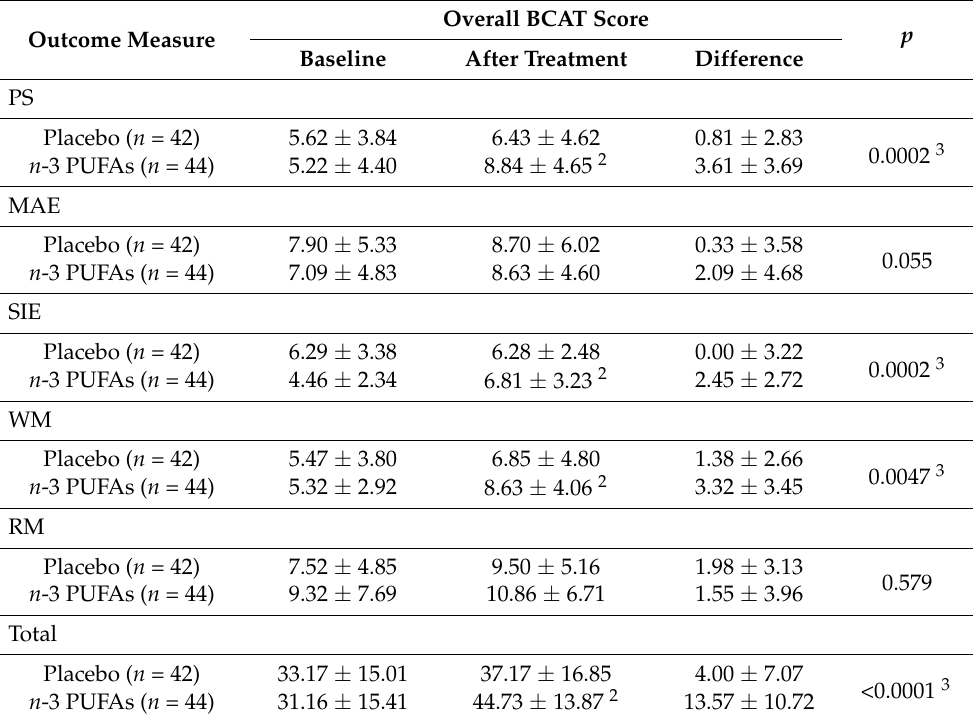
Table 3. The effect of n -3 PUFAs on the BCAT scores of MCI patients 1 .